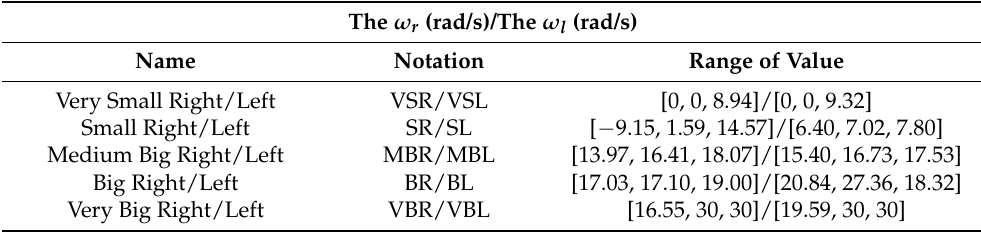
Table 11. The founded suboptimal parameters of the output membership functions.